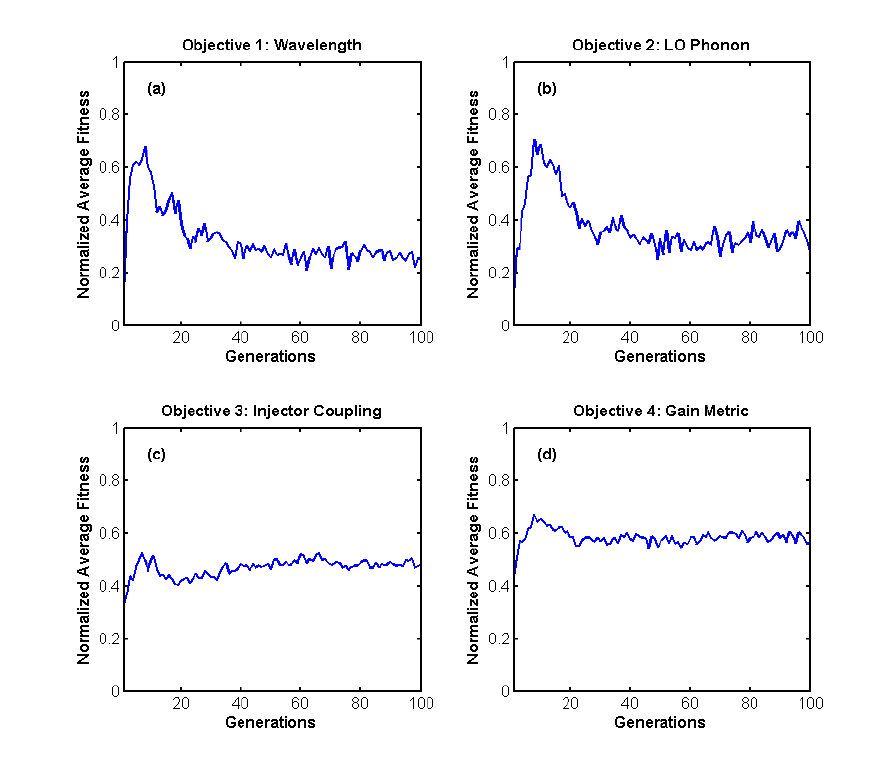
Figure 6. Plots of normalized average fitness per generation for ( a ) wavelength, ( b ) LO phonon, ( c ) injector coupling, and ( d ) gain objectives when initial population was generated